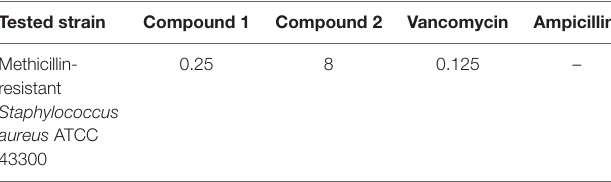
TABLE 1 | The anti-MRSA activity of compounds isolated from strain WA5-2-37 (MIC, µ g/ml, n = 3). Tested strain Compound 1